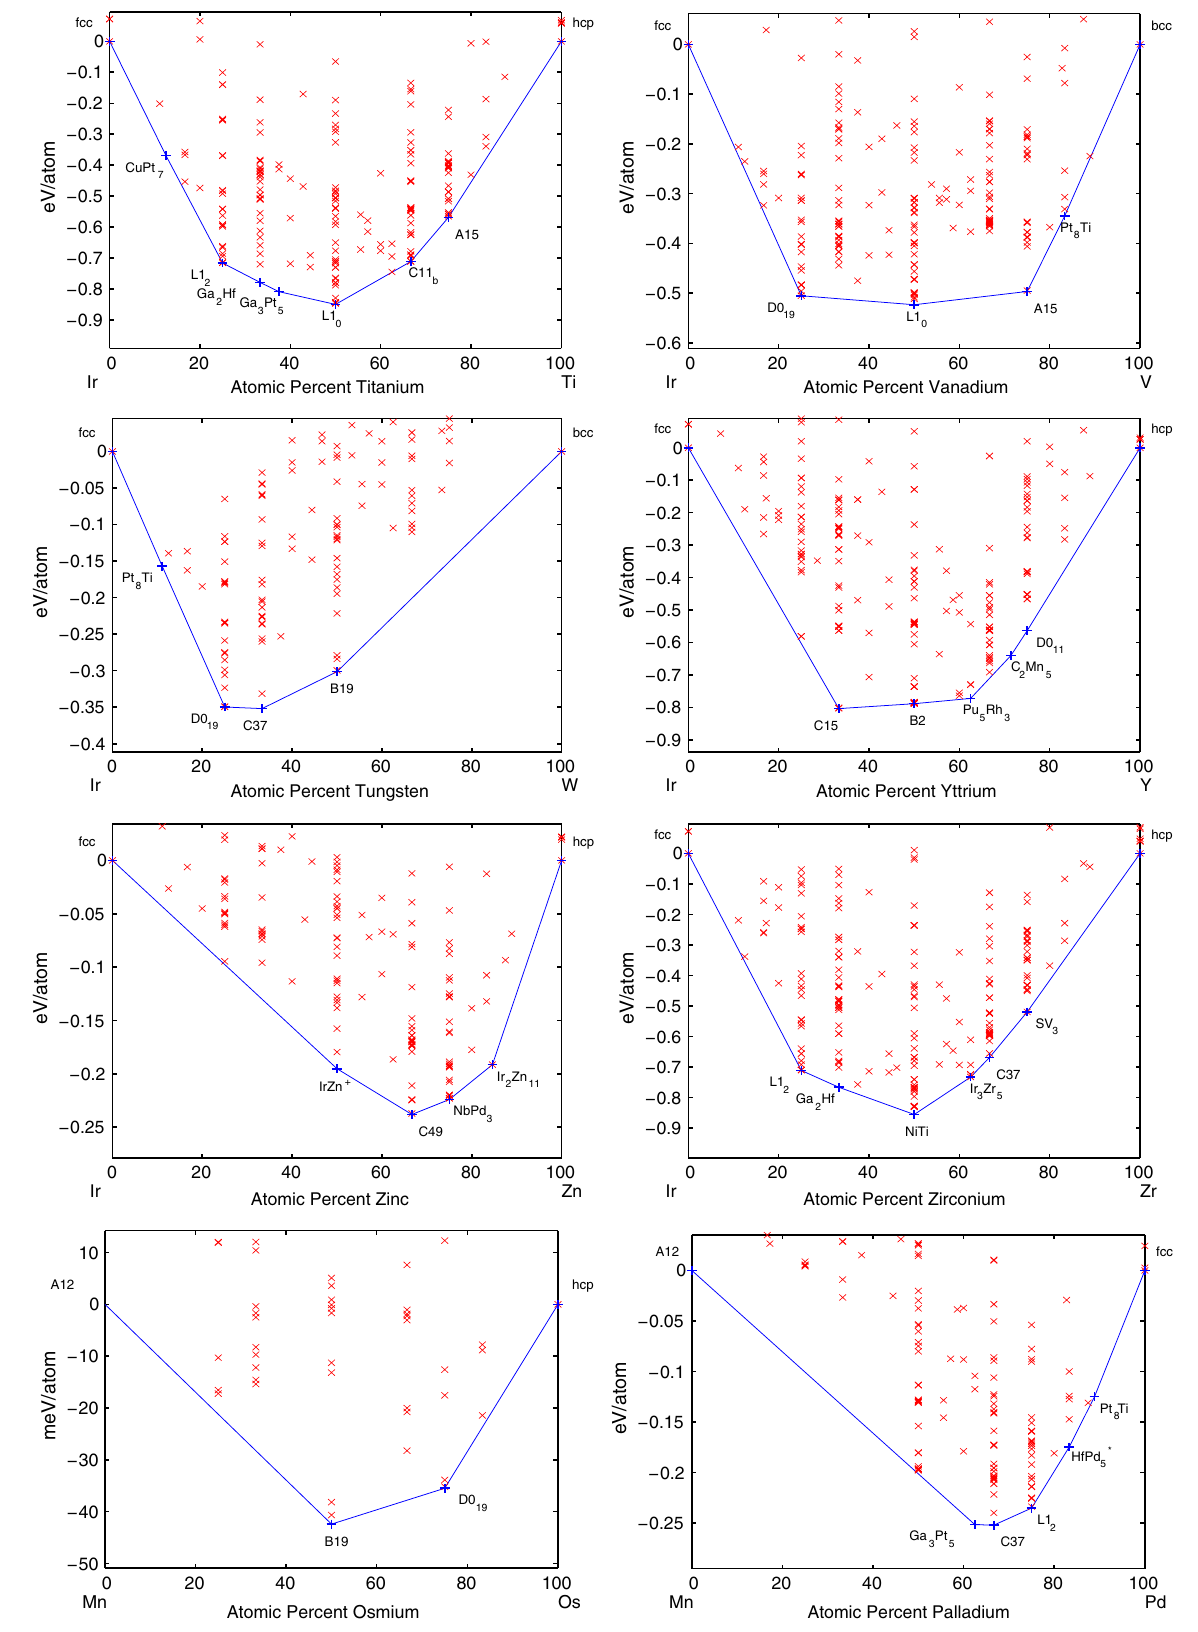
FIG. 10. Convex hulls for the systems Ir-Ti, Ir-V, Ir-W, Ir-Y, Ir-Zn, Ir-Zr, Mn-Os, and